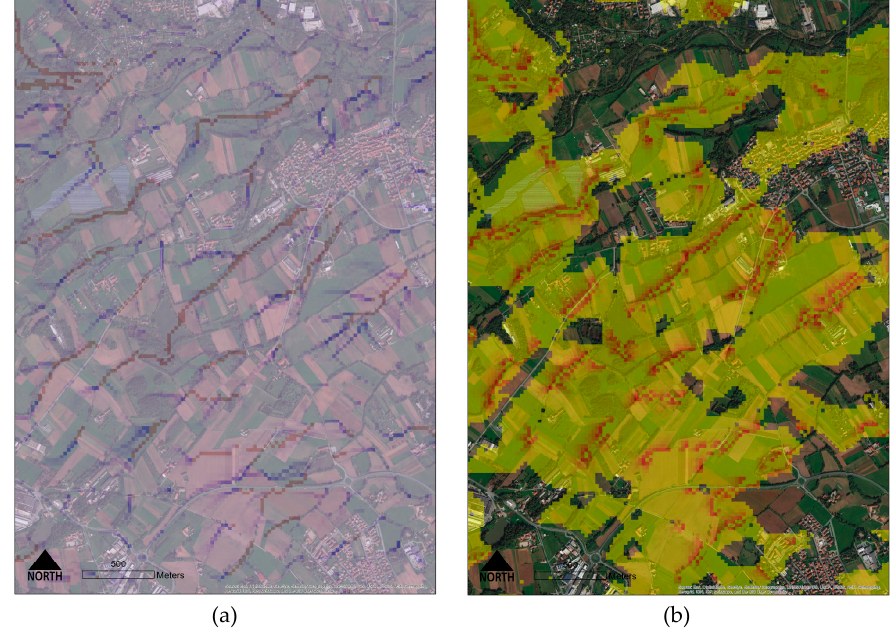
Figure 5. Areas where the nutrient reaches the streams. ( a ) The upstream flows (blue) generate the streams (red) while ( b ) the areas where the nutrient reaches the streams contaminating the water in the catchment are shown.